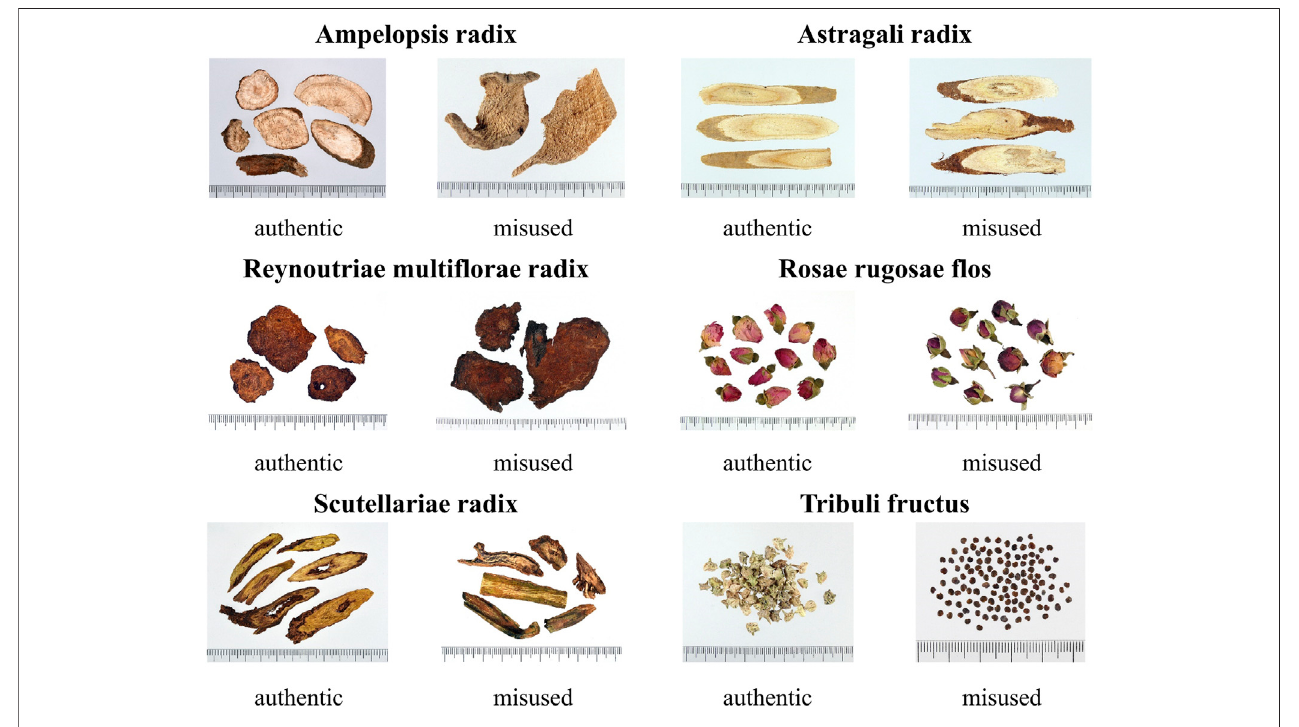
FIGURE 9 | Pictures of authentic or misused medicinal